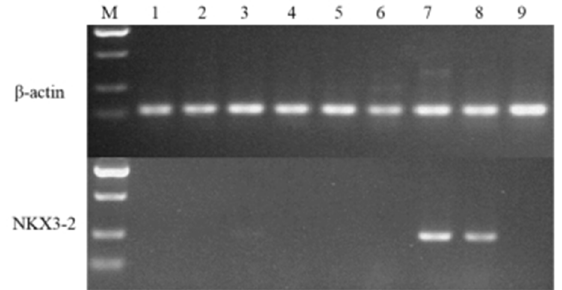
Figure 5. Tissue-specific expression profiles of NKX3.2 were identified by semi-quantitative reverse transcription PCR (M, maker; 1, heart; 2, liver; 3, spleen; 4, lung; 5, kidney; 6, longissimus dorsi; 7, thoracic intervertebral cartilage; 8, lumbar intervertebral cartilage; 9, bone tissue). To explore whether NKX3.2 is involved in chondrocyte development, ATDC5 chon- drogenic progenitor cells and pig primary chondrocytes were treated with Lipofectamine 2000 to overexpress NKX3.2 during culturing in a differentiation medium. Proteoglycan production was reduced by the overexpression of NKX3.2 , as indicated by a reduction in Alcian blue (Figure 6A, B). Moreover, NKX3.2 overexpression significantly promoted the gene expression of the chondrocyte marker collagen type II alpha 1 chain ( COL2A1 ) (Fig- ure 6C,D), while inhibiting the hypertrophic chondrocyte marker collagen type X alpha 1 chain ( COL10A1 ) (Figure 6C,D). Interestingly, the results are consistent in both the ATDC5 cells (Figure 6C) and the pig primary chondrocytes (Figure 6D), suggesting that the over- expression of NKX3.2 delayed the differentiation of chondrocytes into hypertrophic chon- drocytes. Collectively, these data indicate that NKX3.2 can inhibit chondrocyte hypertro- phy.